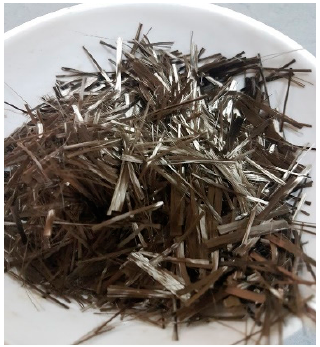
Figure 1. Basalt fiber used in this study.